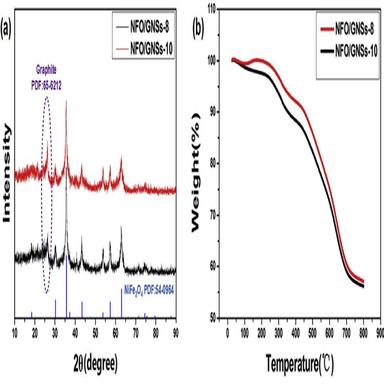
(a) XRD charts and (b) thermogravimetric curves of NFO/GNSs.